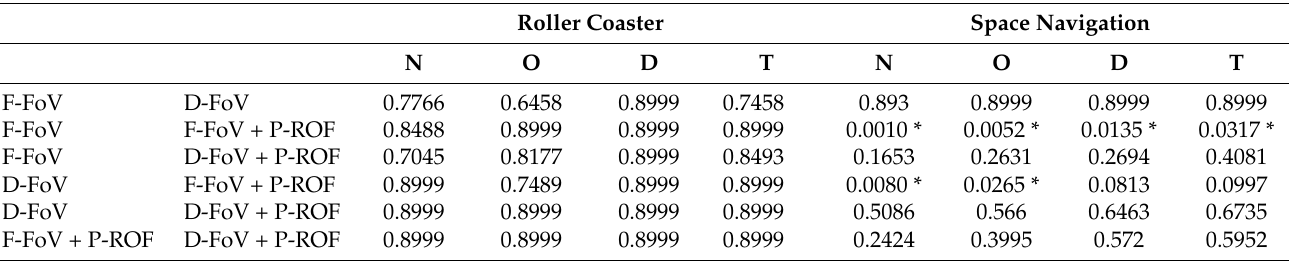
Table 2. Results of the Tukey HSD for the four test conditions. * marks a statistically